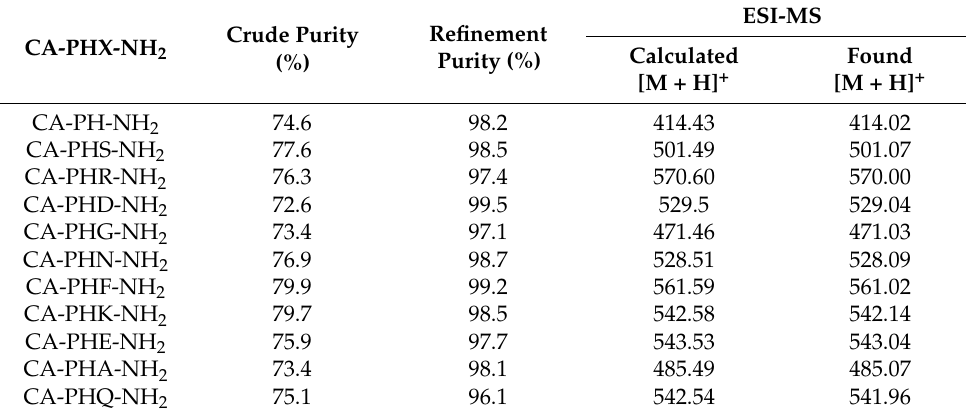
Table 2. Purity and ESI-MS results of CA-PHX-NH 2 .